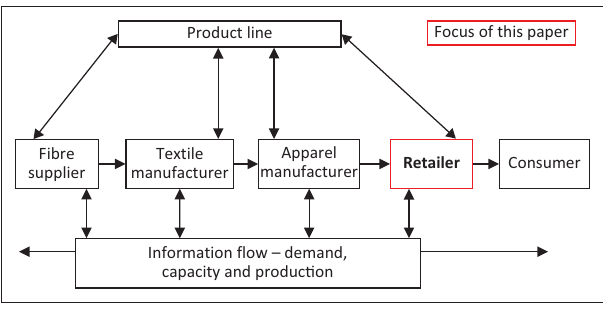
FIGURE 1: The clothing and textile supply chain.